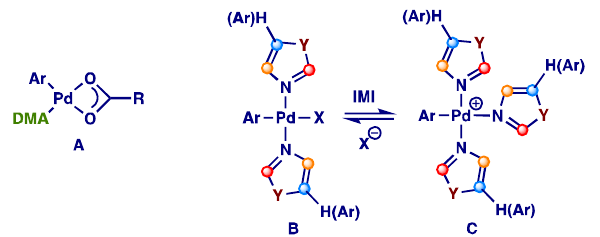
Figure 4. Supposed Pd(II)-catalyzed direct arylation mechanism in aromatic solvents. A : DMA solvate Pd complex; B and C : structures of azole-ligated arylpallaium